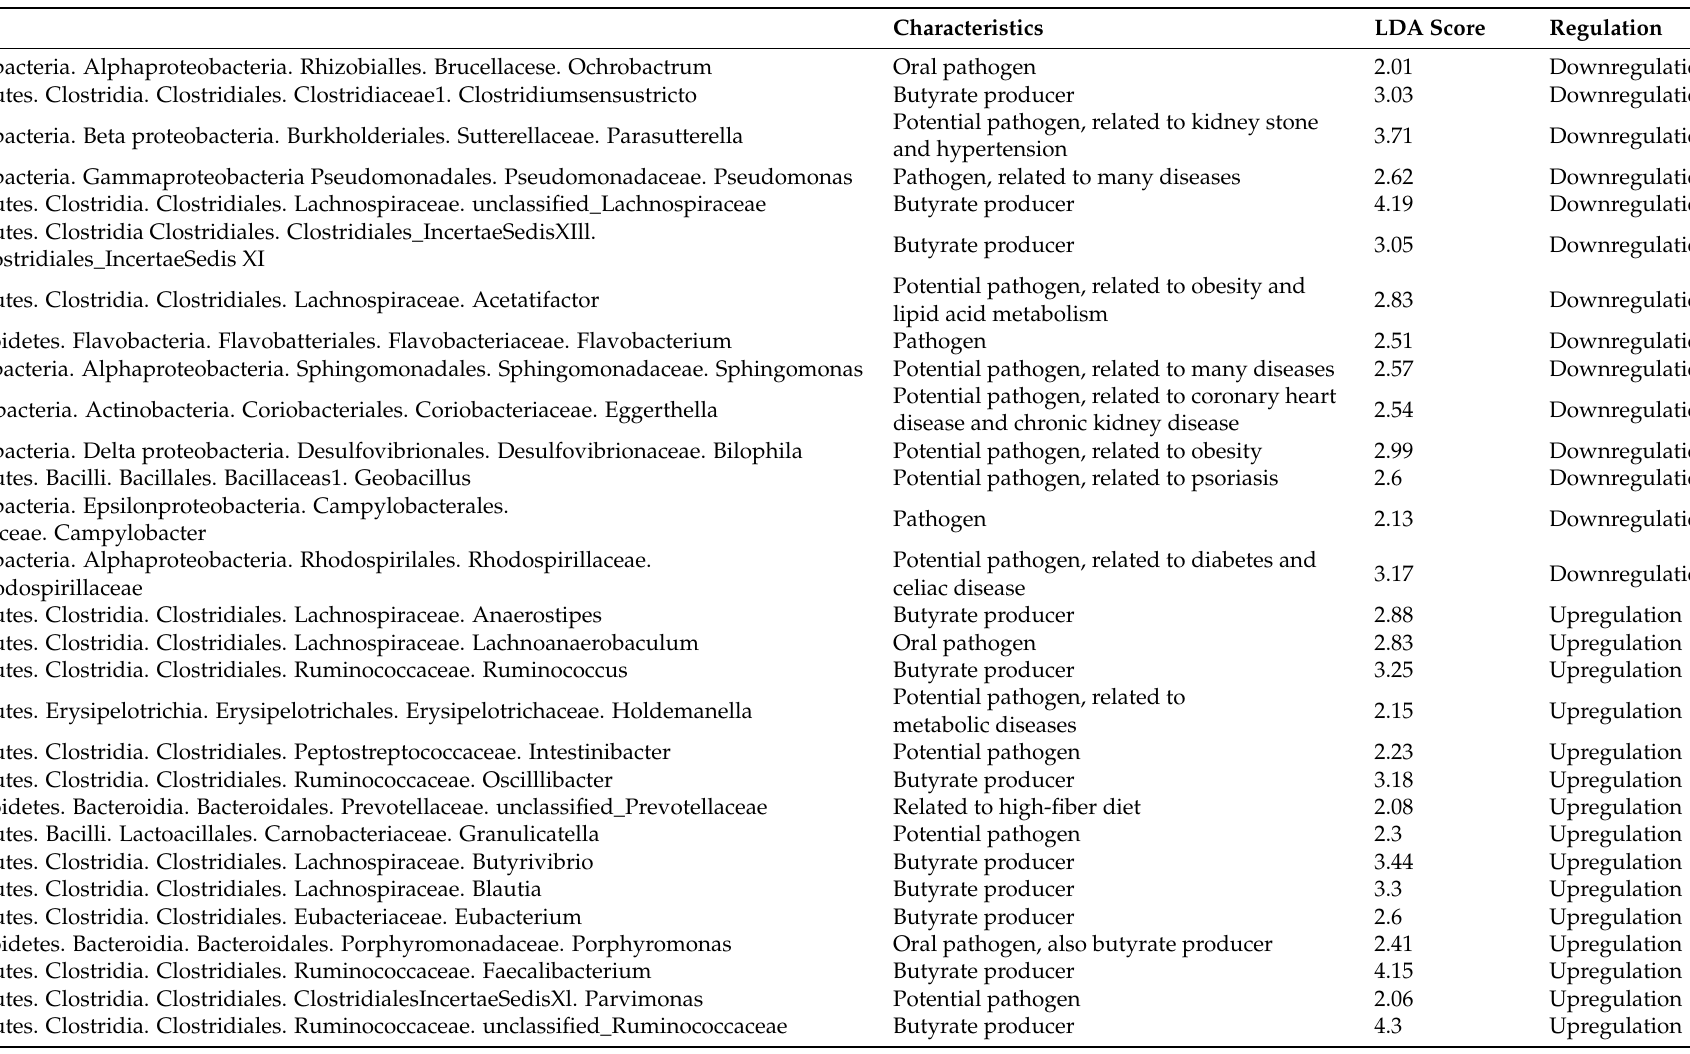
Table 1. Altered genera affected by sea buckthorn puree and their characteristics generated from Disbiome